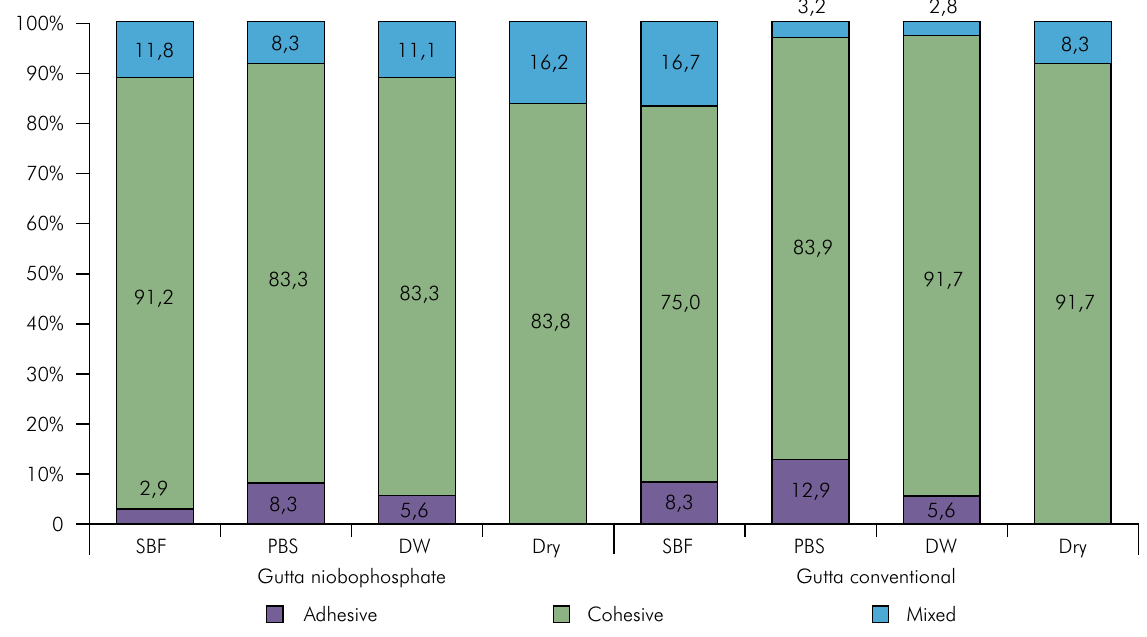
Figure 2. Failure mode distribution per group, expressed in percentage (%).